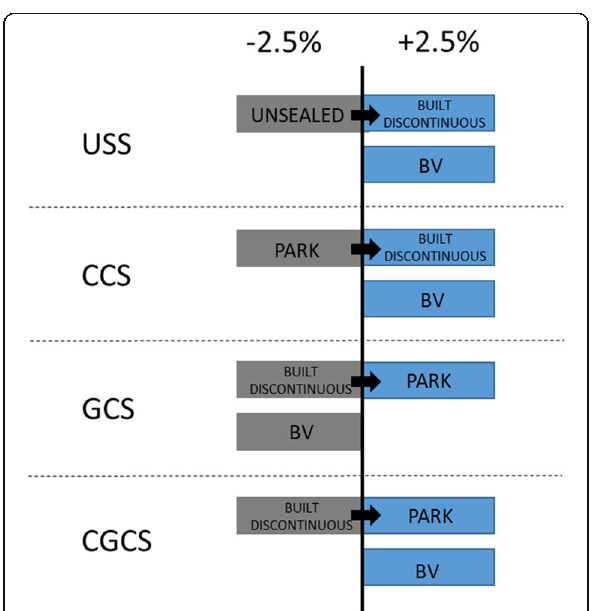
Fig. 1 Land-use modification in the urban development scenarios (USS: Urban Sprawl Scenario, CCS: Compact City Scenario, GCS: Green City Scenario, CGCS: Compact Green City Scenario). In total 10 steps were performed with fixed increments of 2.5% (250 m 2 for land-use and 1000 m 3 for BV (BUILDING VOLUME)